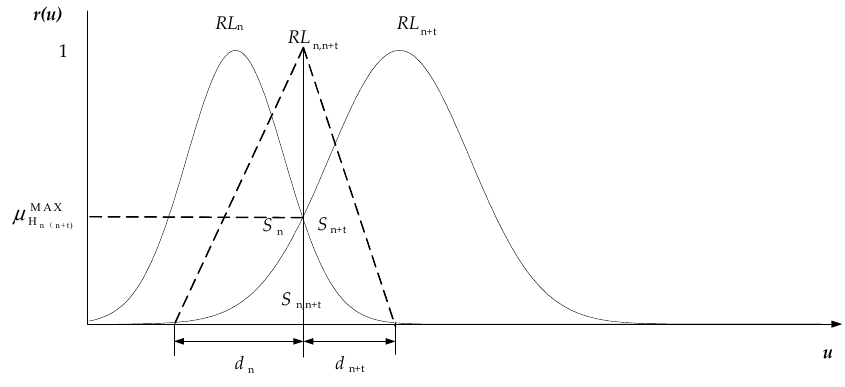
Figure 4. Assignment of fuzzy intersection confidence.